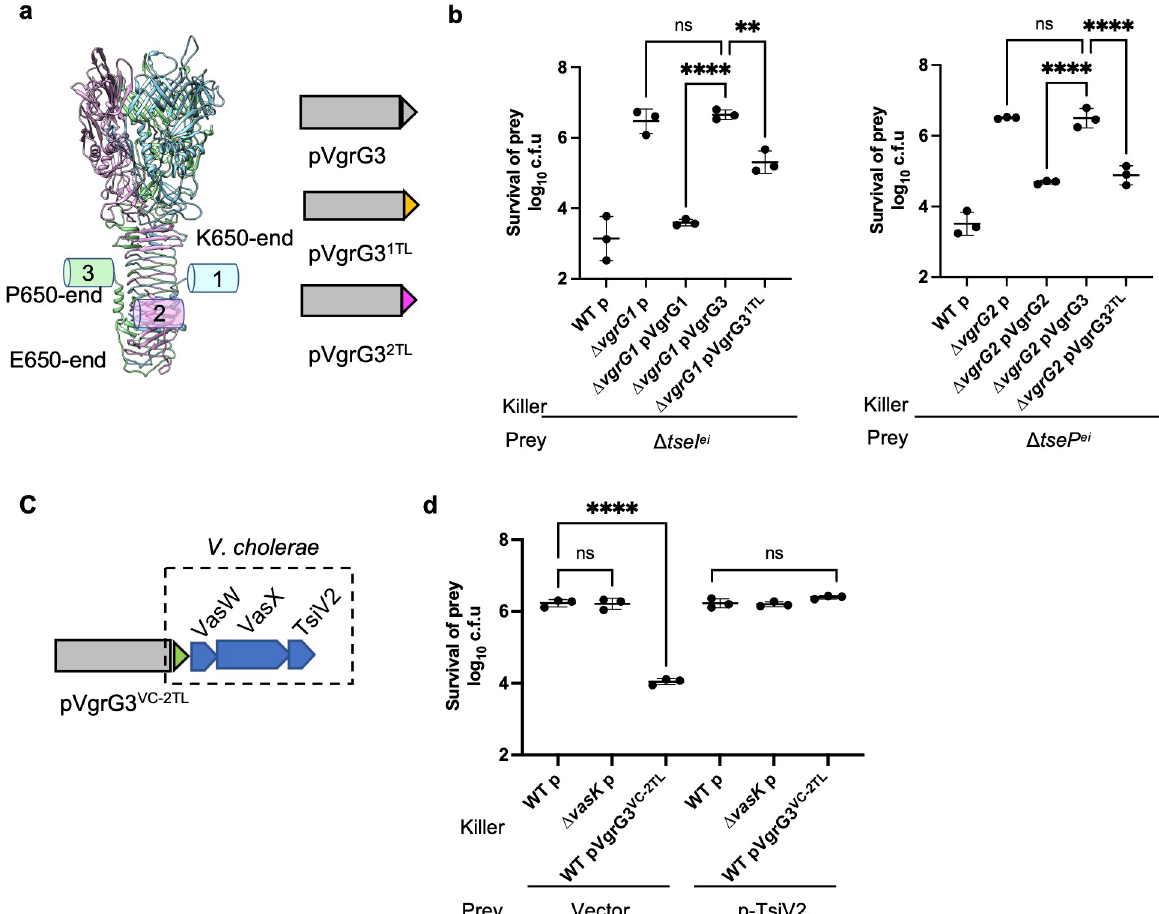
Fig 2. VgrG C-terminal tails dictate effector specificity. A, Schematic of tail swapping of VgrG proteins. Structural model of the VgrG complex was generated using the VgrG1 structure of P . aeruginosa as template (PDB: 6H3L) in Chimera. Chimeric VgrG3 proteins with the tail sequence of VgrG1(K650 to end) or VgrG2(E650 to end) were constructed and expressed on pBAD vectors. B, Competition assay of vgrG mutants expressing chimeric VgrG proteins against the cognate immunity-defective mutants. WT and vgrG mutants were transformed with an empty pBAD plasmid (p) or VgrG-encoded plasmids as indicated. Killer and prey strains were co-incubated on LB plates with 0.01% arabinose and survival of prey was enumerated by serial dilutions and plating on selective media. C , Chimeric VgrG3 with the VasX effector module of V . cholerae . A pBAD plasmid expressing chimeric VgrG3 with the C-terminal tail of V . cholerae VgrG2 and its downstream chaperone (VasW), effector (VasX) and immunity (TsiV2) was constructed. D, Competition assay of WT expressing an empty plasmid (p) or the chimeric VgrG against an SSU mutant prey expressing an empty vector or the immunity protein TsiV2. The Δ vasK mutant serves as a T6SS null control, and the prey strain is the Δ vgrG1&3 double mutant. For B&D, error bars indicate the mean +/- standard deviation of at least three biological replicates and statistical significance was calculated using one-way ANOVA analysis. �� P < 0.01, ���� P < 0.0001, ns: not